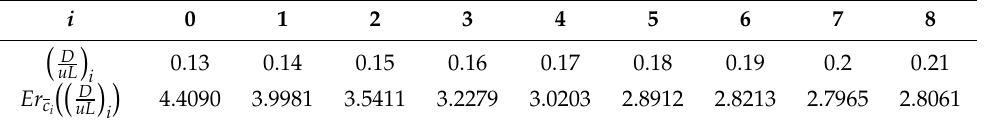
Table 4. The values of the error function.